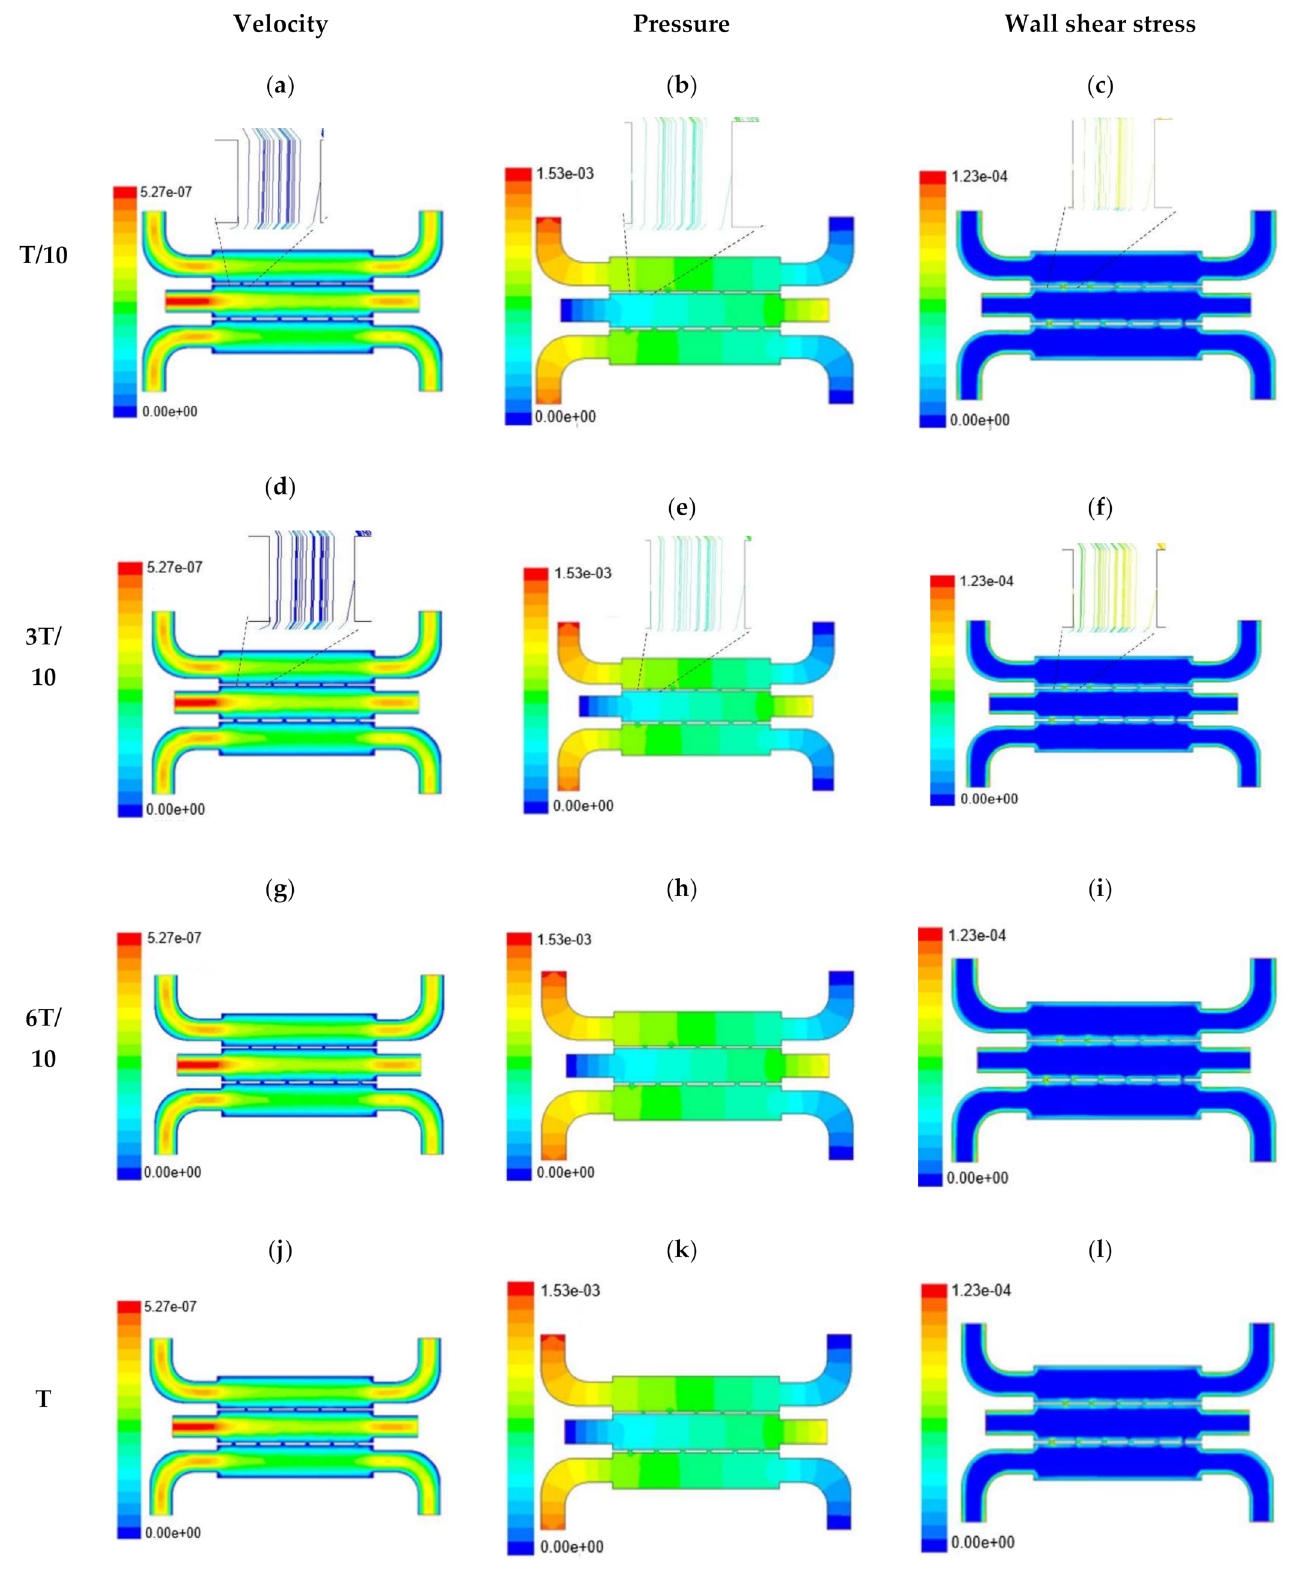
Figure 5. Numerical simulation of fluid flow inside the chip design 1 at flow rate of 20 µ L/min. The different time step was taken to understand the profile of velocity ( a , d , g , j ), pressure ( b , e , h , k ) and wall shear stress ( c , f , i , l ) along the